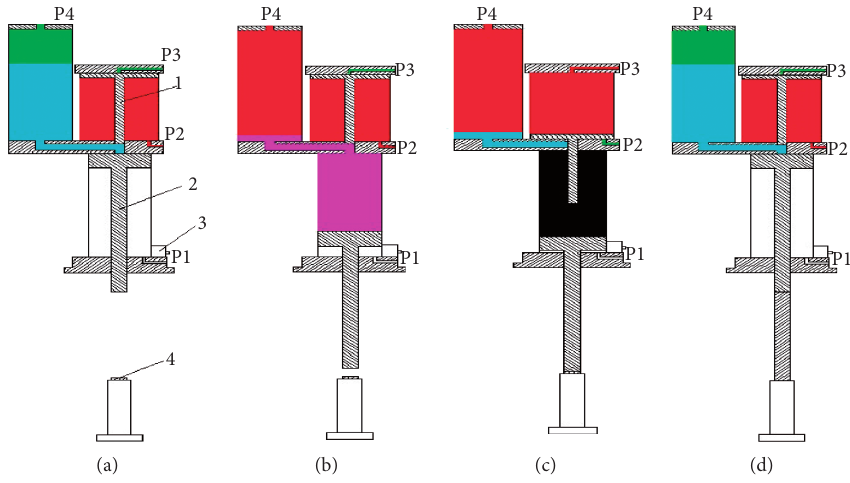
Figure 3: Schematic of the gas-hydraulic pressurized